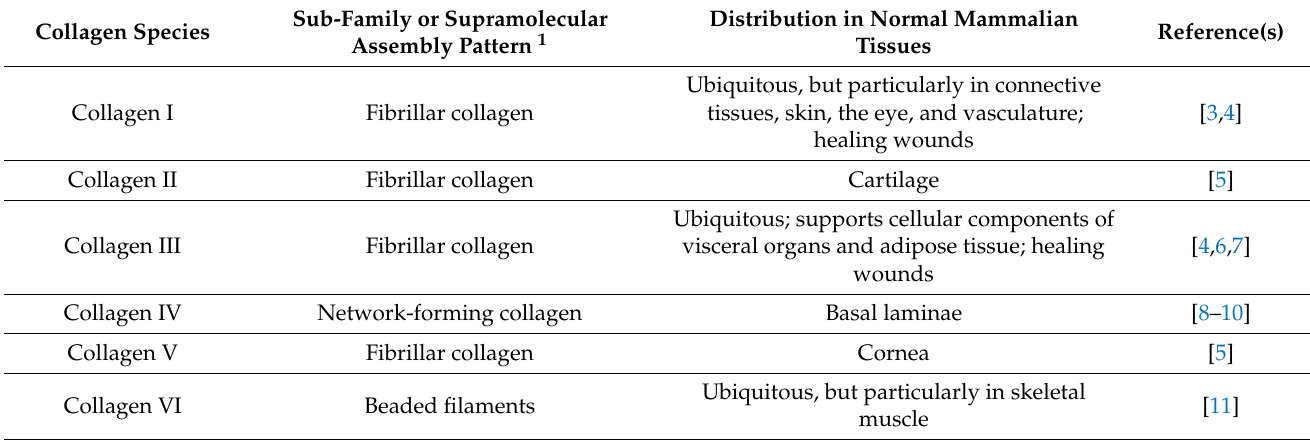
Table 1. Collagen species, sub-families, and normal tissue